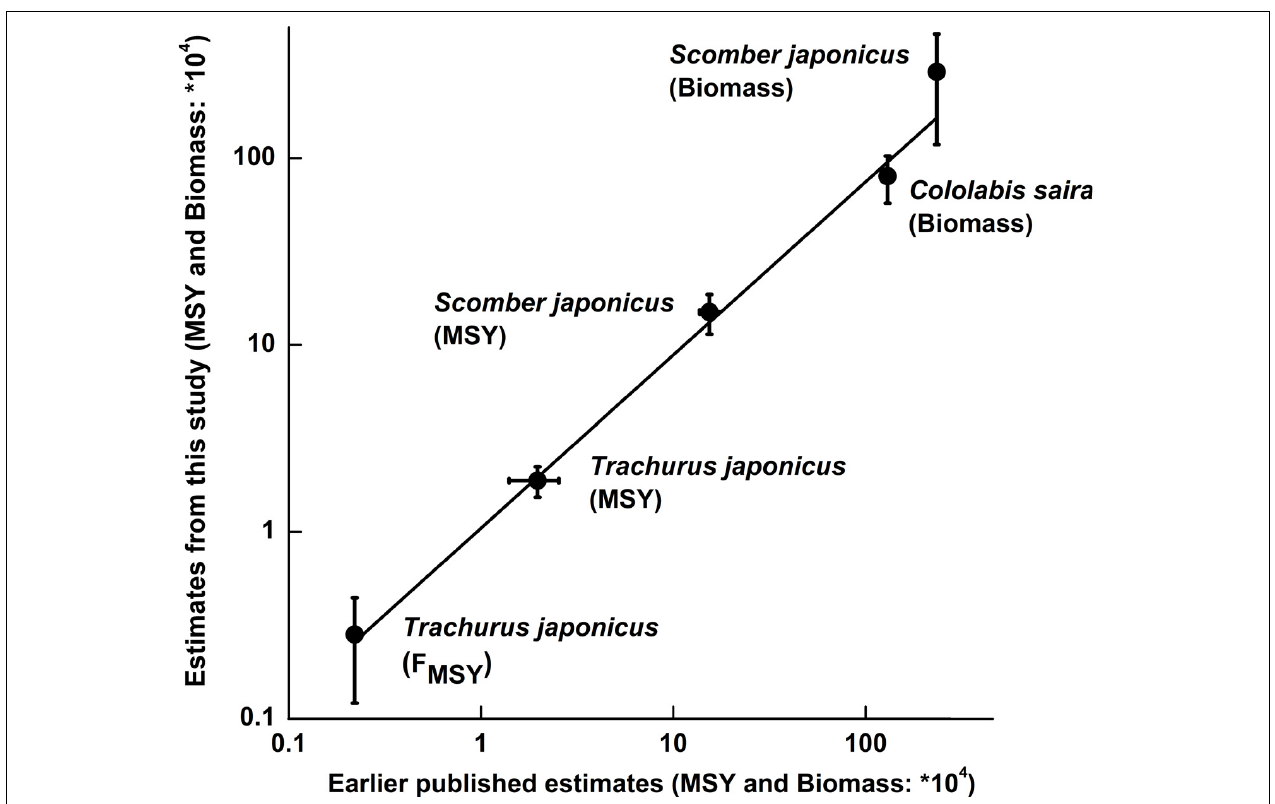
FIGURE 5 | Plot of estimates obtained with the CMSY and BSM methods vs. the corresponding values estimated using other models [ T. japonicus from Zhang and Lee (2001); S. japonicus from Choi et al. (2004) and Yatsu (2019); Cololabis saira from Yatsu (2019)]. The vertical bars refer to the confidence intervals of the CMSY and BSM results, while the two horizontal bars express ranges whose mid-ranges were used as point estimates.